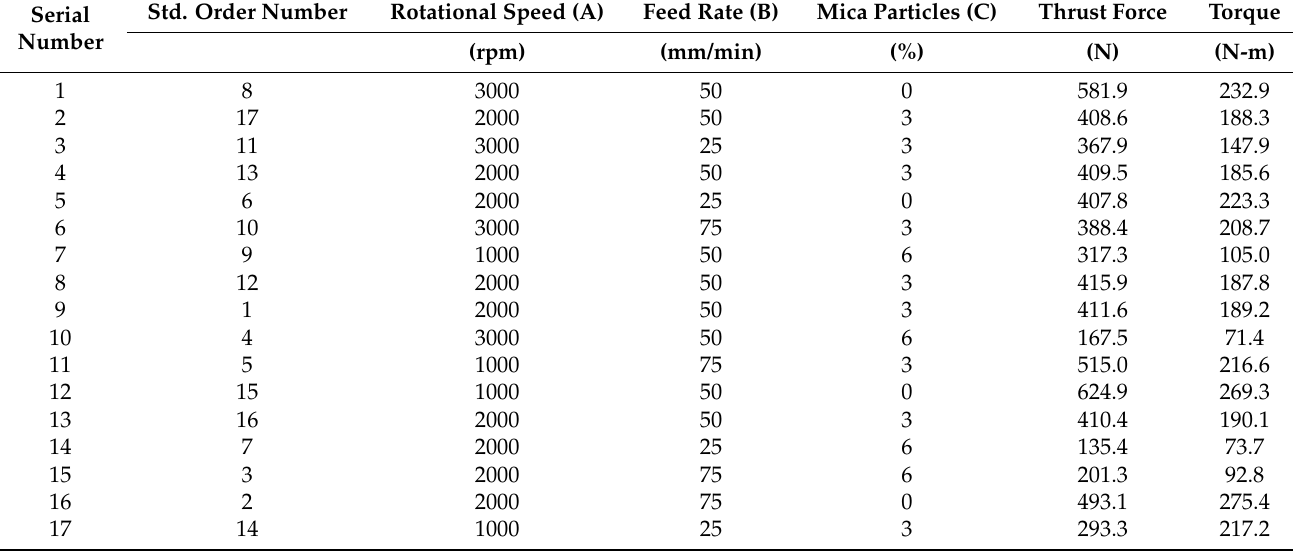
Table 3. Box-Behnken Design (BBD) of Experiments and their